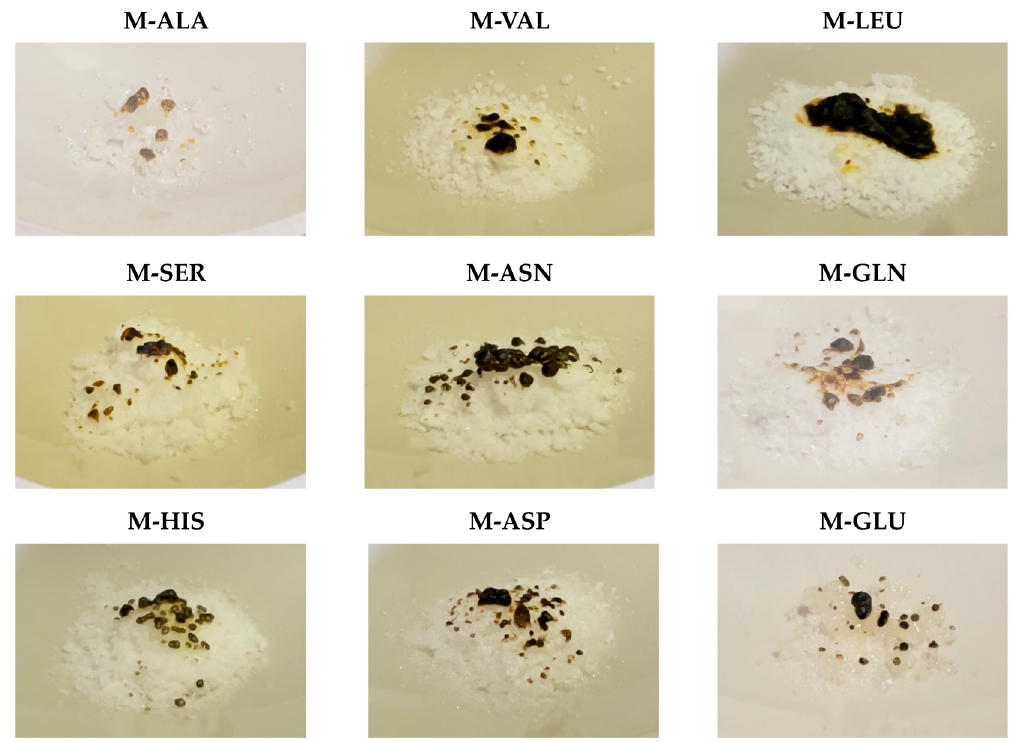
Figure 3. Snapshots of PAA ignition test